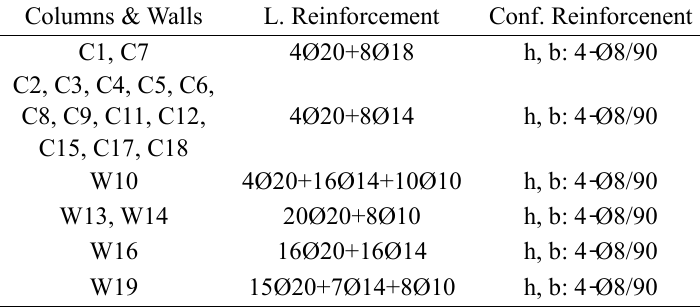
Longitudinal and confinement reinforcement of the vertical resisting elements. Columns & Walls L. Reinforcement Conf. Reinforcenent